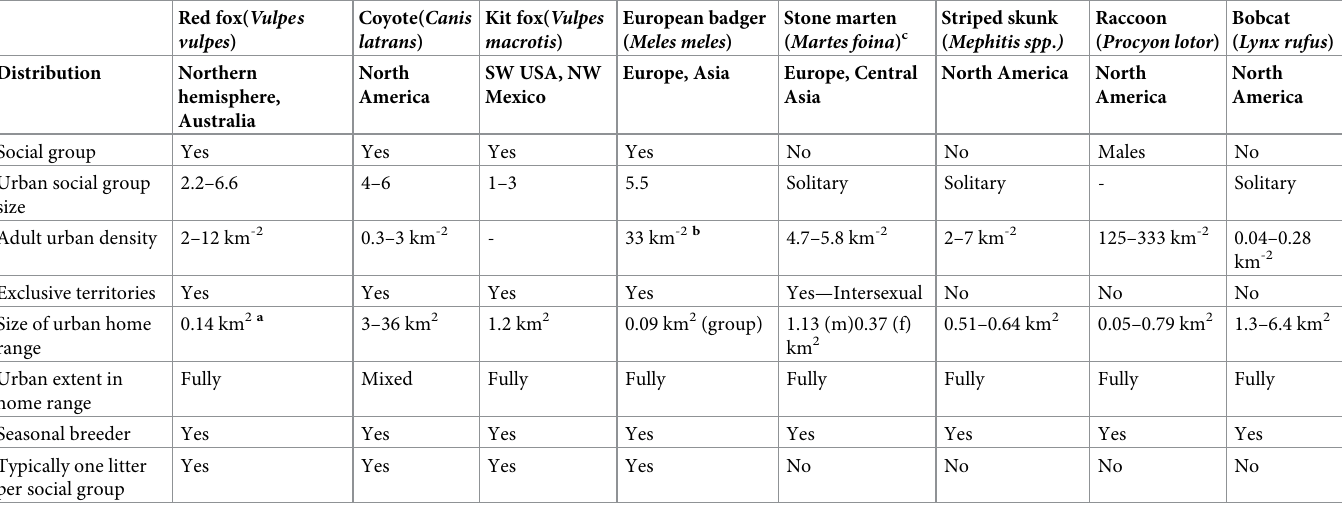
Table 3. Ecological traits of selected urban